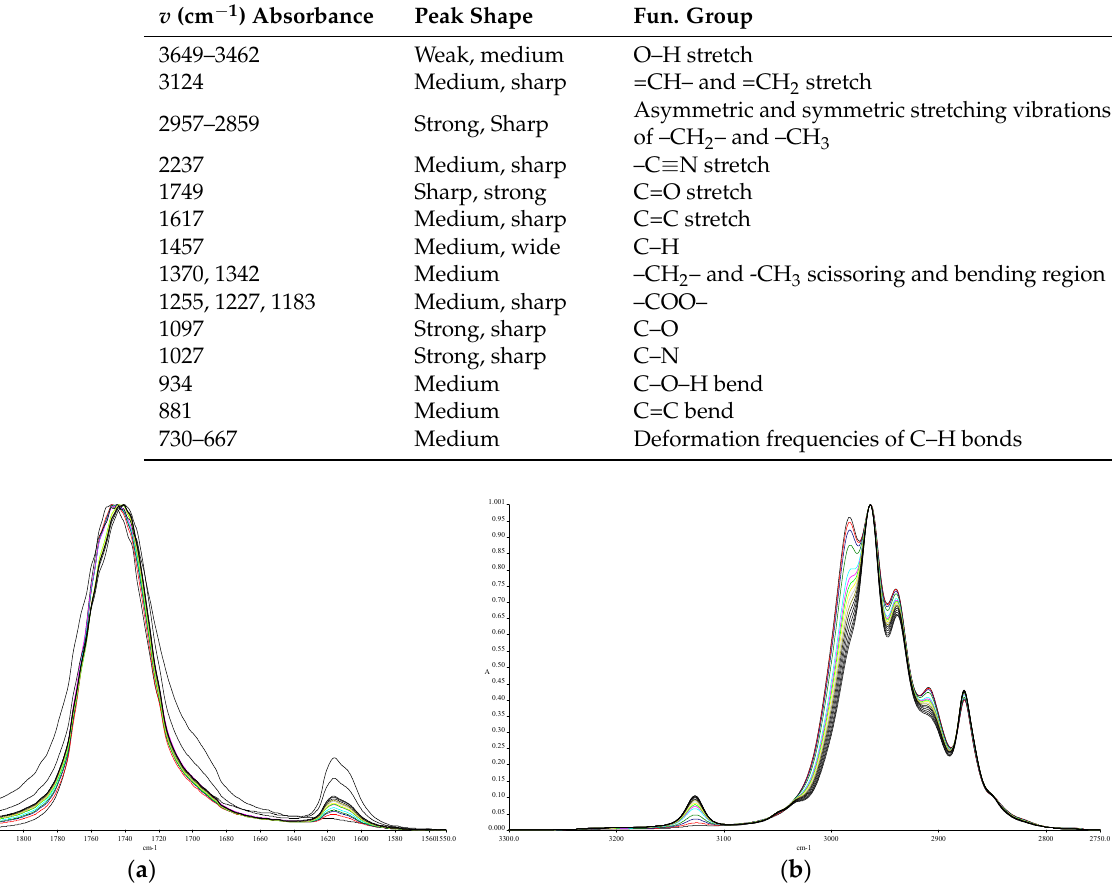
Figure 3. Peaks’ changes in FT-IR spectra at1950–1500 cm −1 ( a ) and 3300–2750 cm −1 ( b ) regions, indicating the polymerisation progress of the adhesive.